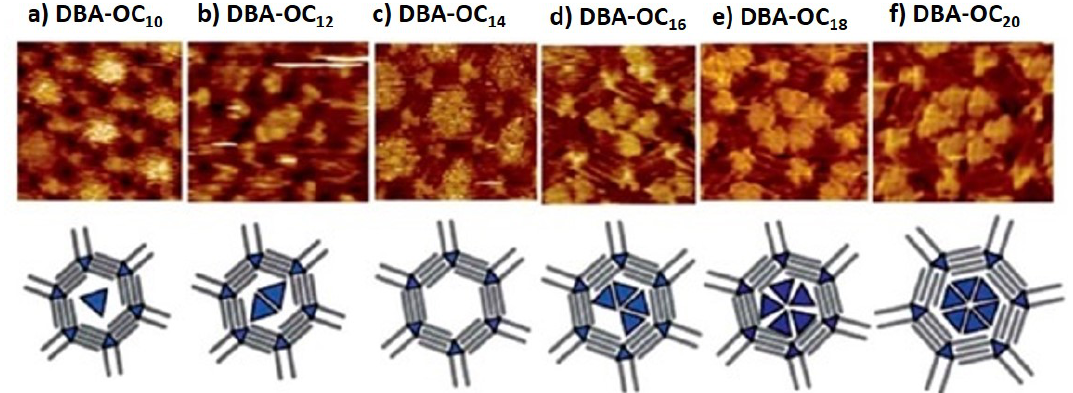
Figure 5. STM images of nanoporous monolayers developed using DBA building blocks with different chain lengths ( a ) DBA - OC 10 , ( b ) DBA - OC 12 , ( c ) DBA - OC 14 , ( d ) DBA - OC 16 , ( e ) DBA - OC 18 , and ( f ) DBA - OC 20 , and therefore consequently different pore sizes for a host-guest network of (DBA-OCns)-TNG. A schematic model of the host-guest systems is represented below of the corresponding STM image. Different nanowell sizes can incorporate different numbers of a guest molecule (TNG). (Reprinted with permission from reference [51]. Copyright 2010 The Royal Society of Chemistry).